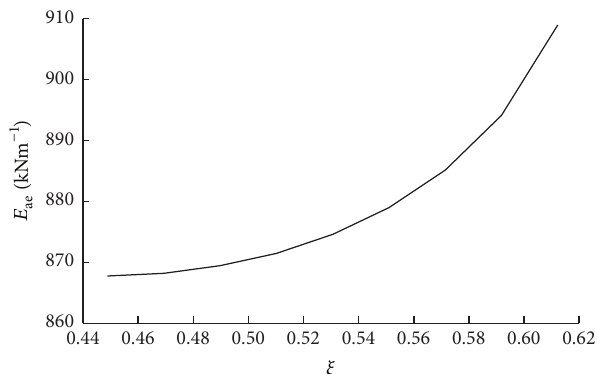
Figure 5: The magnitude of seismic active earth pressure.